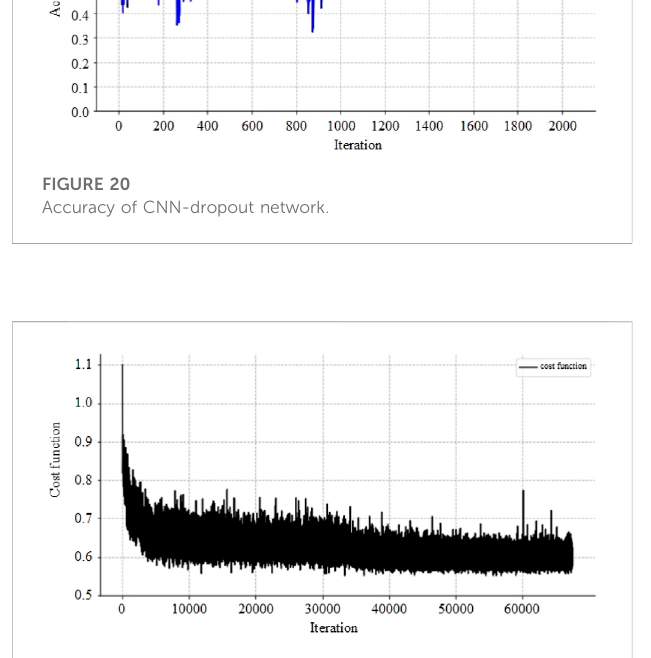
FIGURE 21 Cost function of FFT-CNN-dropout network.